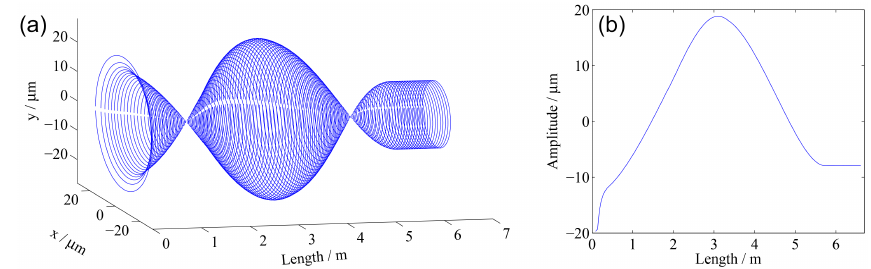
Figure 16. Vibration amplitude of the concrete mixing drum. (a) Vibration mode. (b) Response curve.